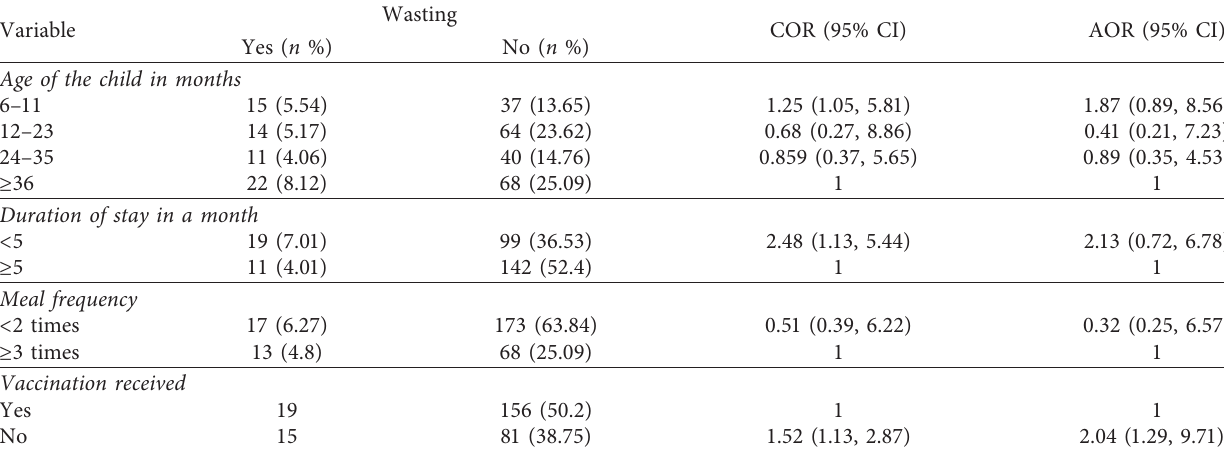
Table 5: Factors associated with wasting among orphan under-five children in Addis Ababa, Ethiopia, 2020 ( n � 271). Variable